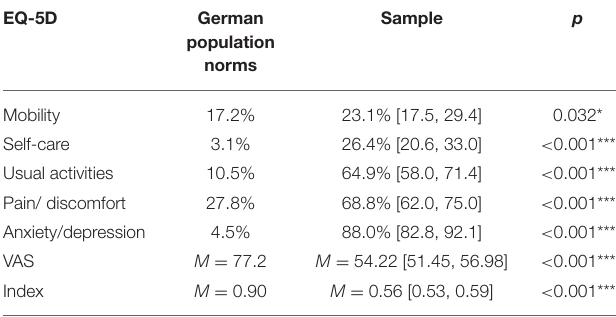
TABLE 2 | Self-reported EQ-5D scores after age standardization, mean EQ VAS, EQ Index and proportions (%) of respondents scoring any problem. EQ-5D